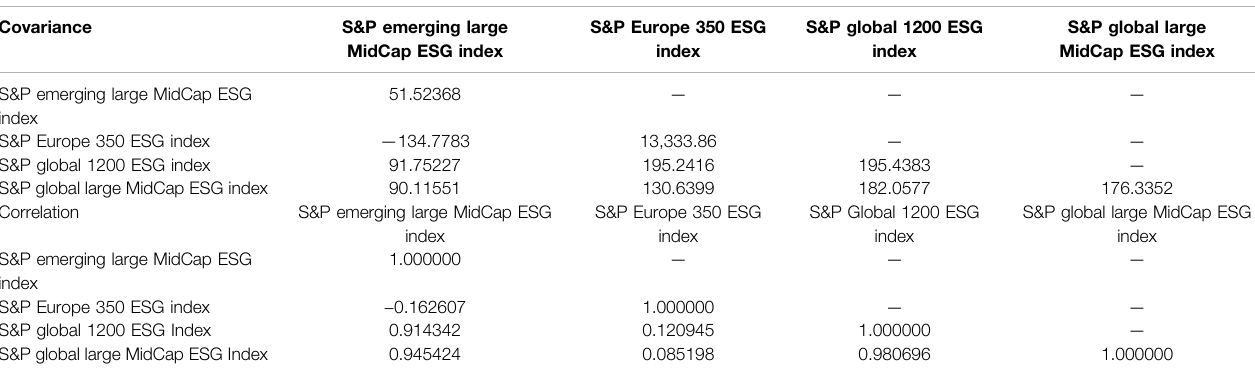
TABLE 3 | Covariance and